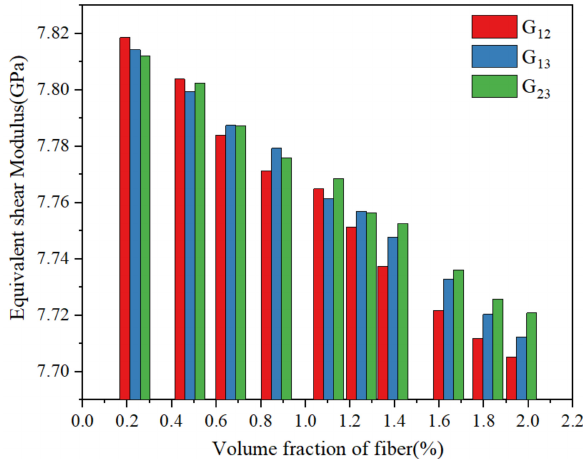
Figure 13. Variation trend in equivalent shear